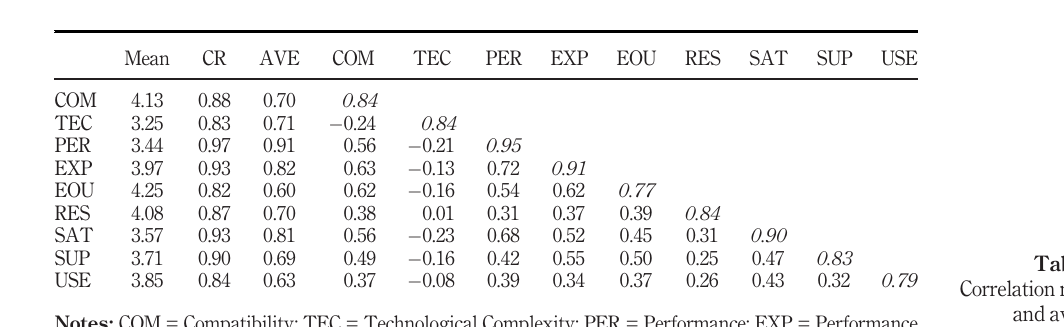
Table II. Correlation